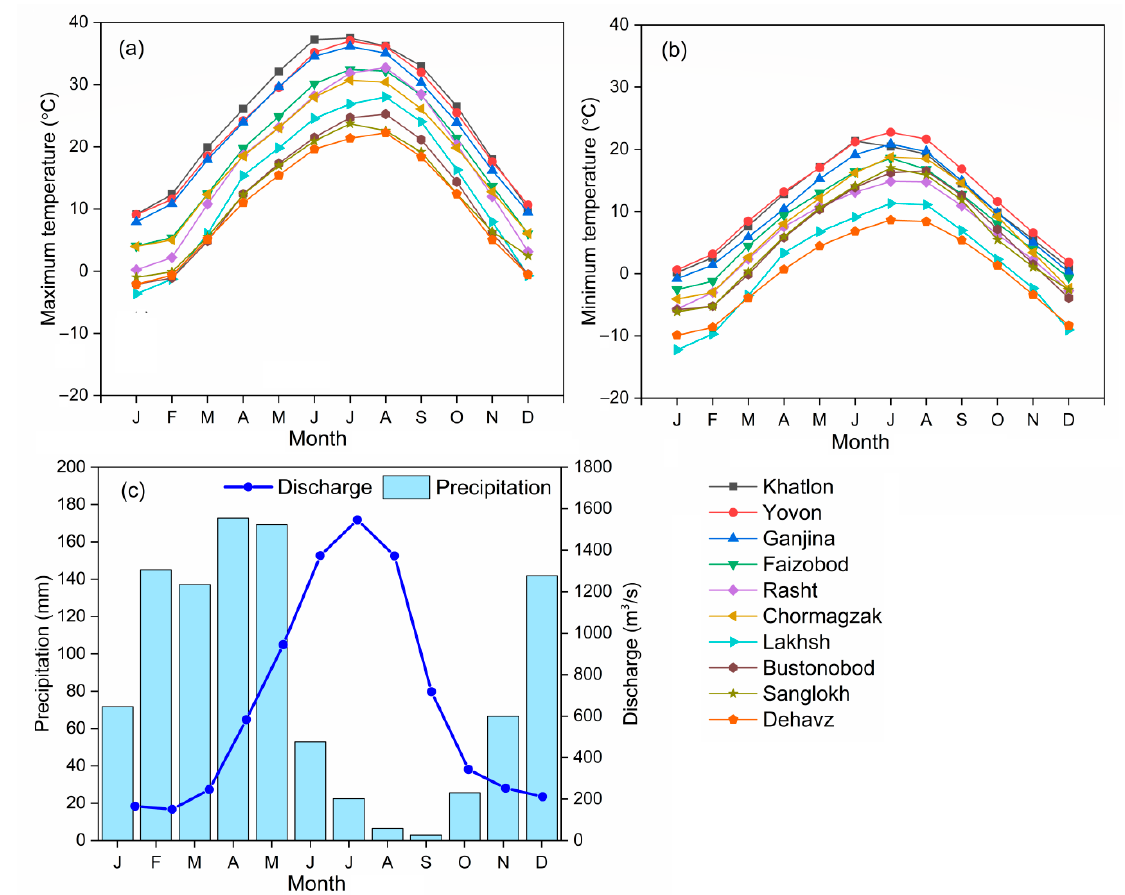
Figure 2. The mean monthly values of ( a ) the maximum temperature, ( b ) the minimum temperature, and ( c ) the streamflow and average monthly precipitation in the Vakhsh River Basin, Central Asia, from 2000 to 2013.